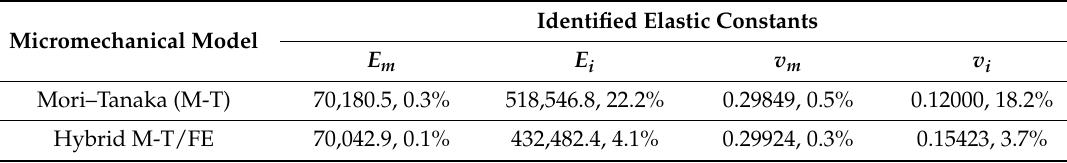
Table 7. Identified elastic constants of particle reinforced composite constituents.